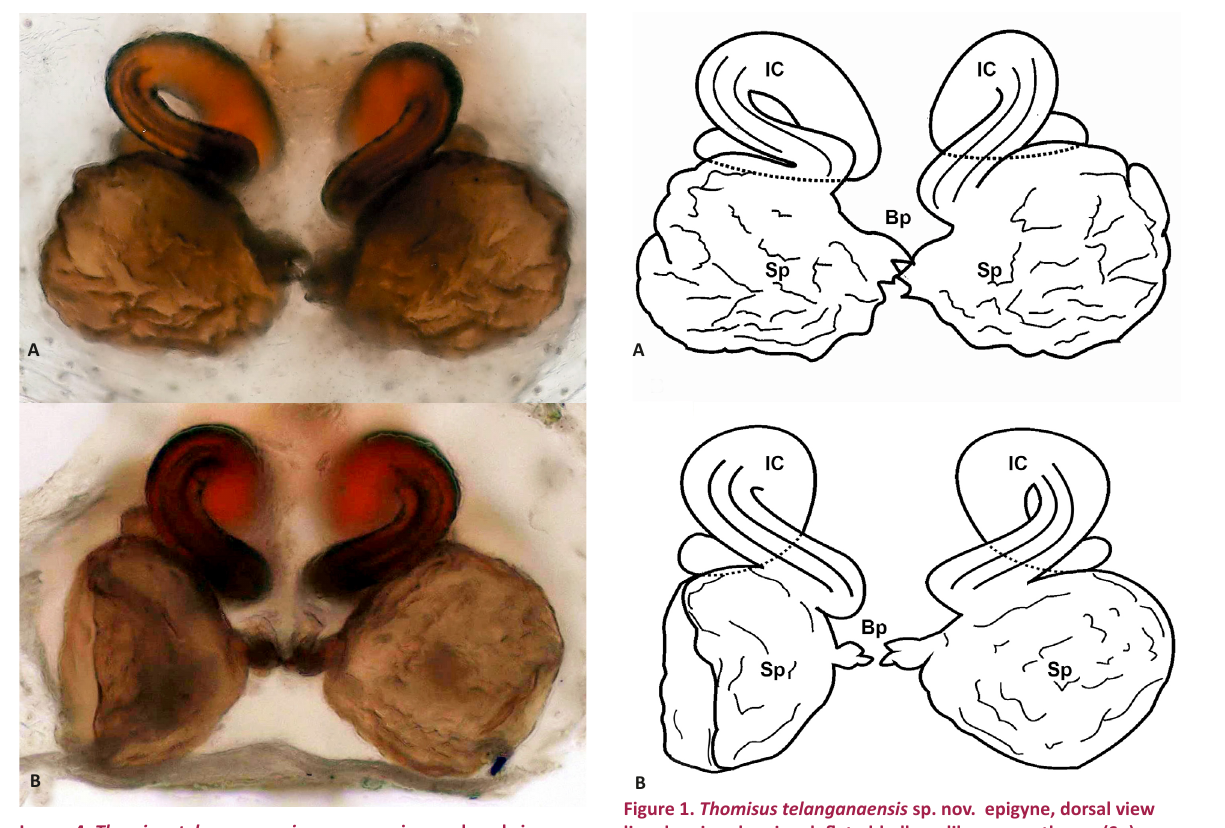
Image 4. Thomisus telanganaensis sp. nov. epigyne, dorsal view: A - Holotype; B - Paratype.